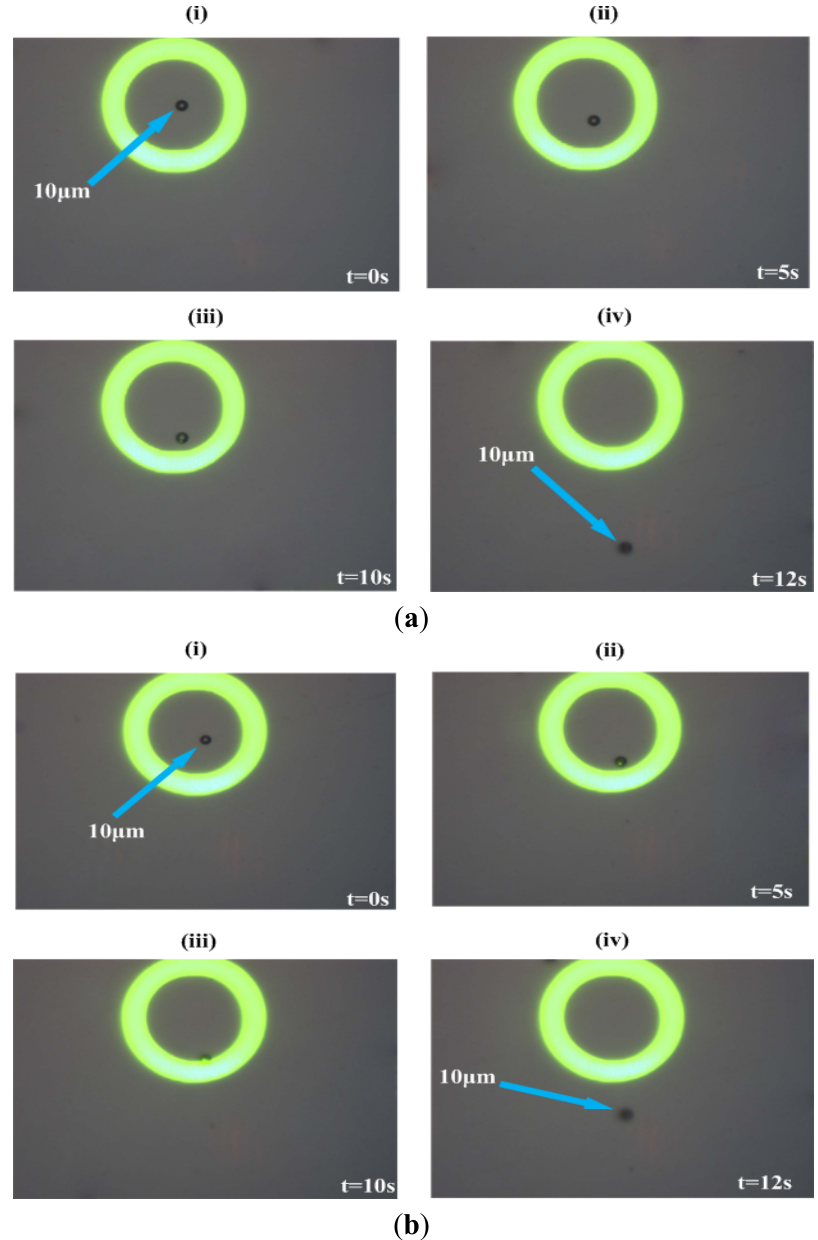
Figure 8. Experimental process of the ODEP manipulation of a 10 μ m polystyrene bead using the square wave ( a ); sine wave ( b ); and triangular wave ( c ). (a) ( i ) : No bias voltage was applied across the liquid medium; ( ii ): Bias voltage was applied and the stage on which the ODEP chip is placed moves at a velocity of 50 μ m/s; the bead is trapped in the “ring” as it moves; ( iii ): The velocity of the stage increases to 250 μ m/s, and the bead remains trapped; ( iv ): The bead lags behind when the velocity of the stage exceeds 260 μ m/s; (b) Steps in ( i ) and ( ii ) are the same as those explained in (a); ( iii ): The velocity of the stage is increased to 135 μ m/s; ( iv ): The bead lags behind when the stage velocity exceeds 140 μ m/s; (c) Steps in ( i ) and ( ii ) are the same as those explained in (a); ( iii ): The stage velocity is increased to 80 μ m/s; ( iv ): The bead lags behind when the stage velocity exceeds 85 μ m/s. Thus the maximum velocities for manipulating a 10 μ m bead utilizing the square wave, sine wave, and triangular wave are 260, 140, and 85 μ m/s,